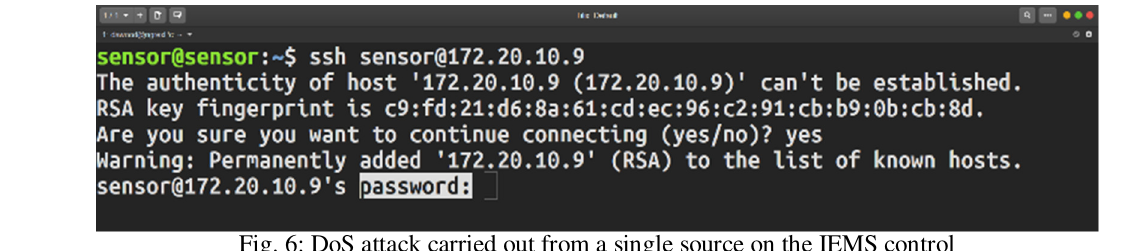
Fig. 6: DoS attack carried out from a single source on the IEMS